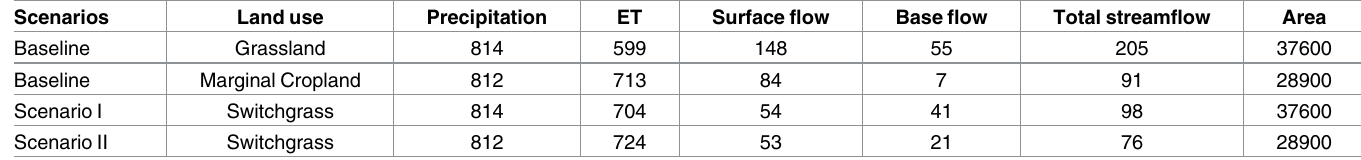
Table 3. Summaryof averageannual water balance (in mm) during the simulation period (2002 through 2011) for grasslands and marginal crop- lands in the baseline simulation, and switchgrass growing on existing grasslands and on marginal croplands along with the area occupied/con- verted (in